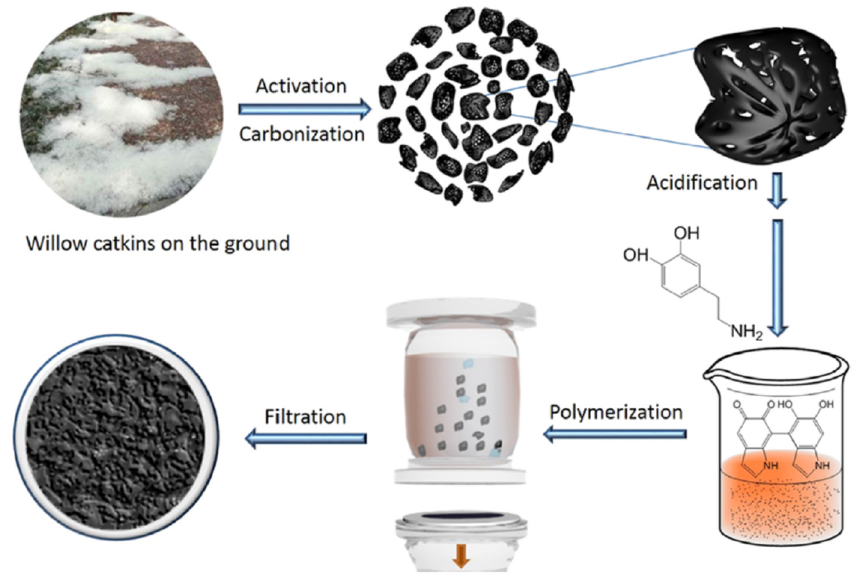
Figure 11. Photo and schematic showing the preparation of willow catkin-derived active carbon and the composite membrane. Reprinted from [20], ©2020 The Authors. the composite membrane. Reprinted from [20], ©2020 The